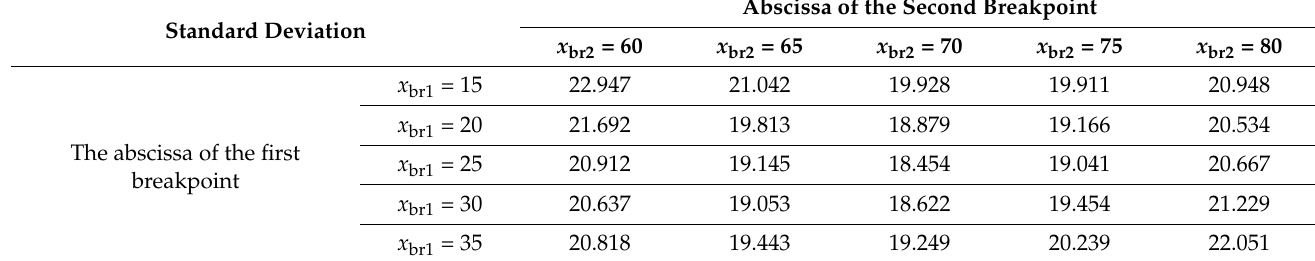
Table 3. Computation results for standard deviation.